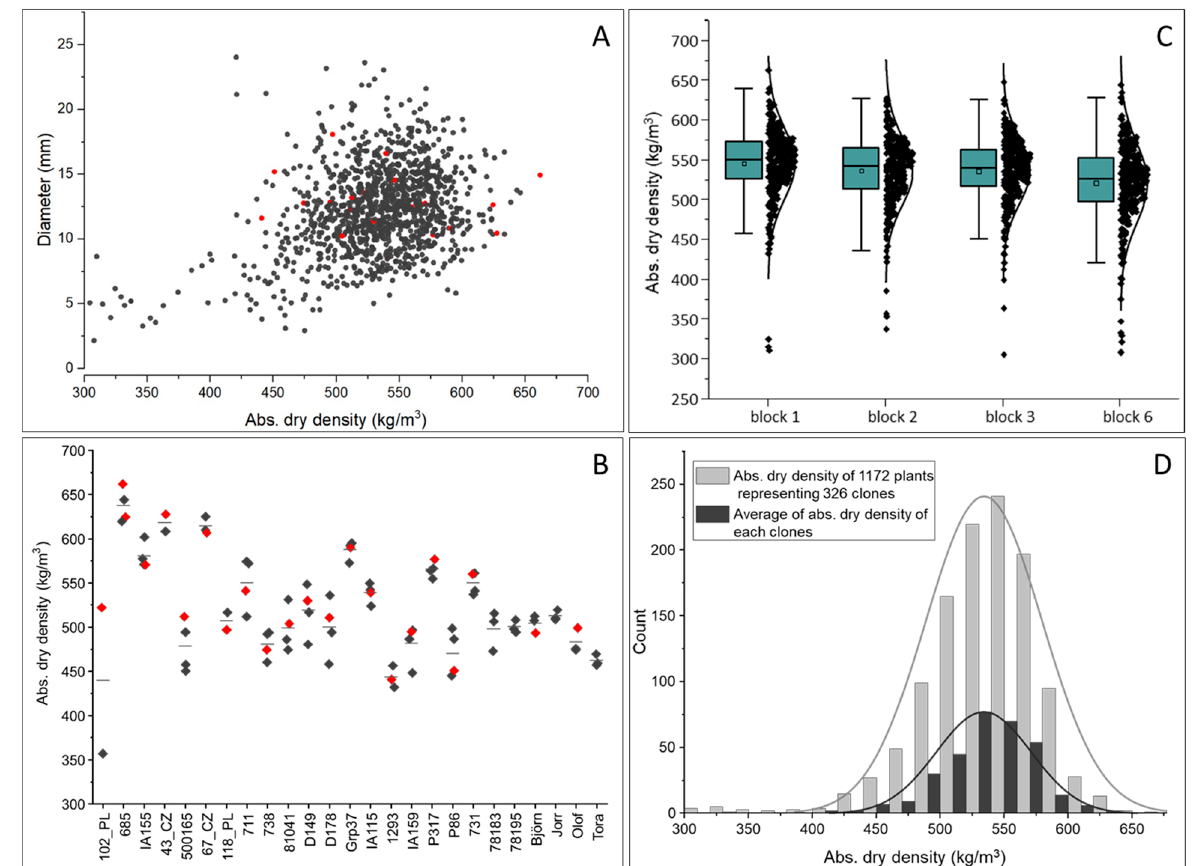
Figure 2. Absolute dry weight density (Abs. dry density) measurements for the 326 genetically distinct S. viminalis clones and commercial varieties. ( A ) Scatterplot of the 326 clones and replicates. Red dots indicate replicates selected for further studies; ( B ) selected genetic and commercial clones; ( C ) density distribution variations with different blocks; ( D ) density plotted as individual and average values.